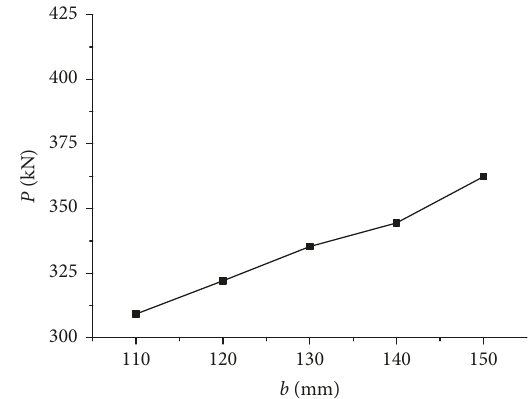
Figure 12: Relationship between concrete thickness and shear capacity.